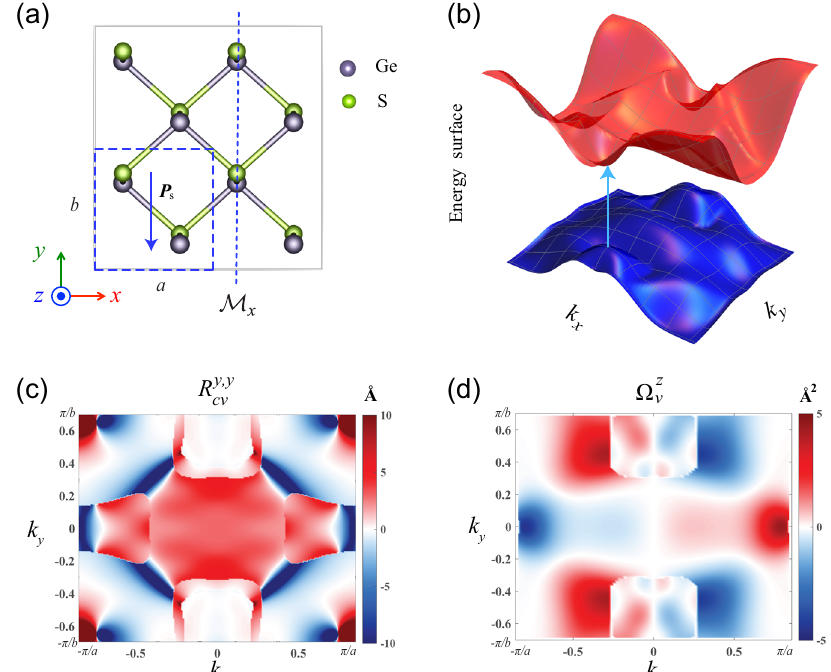
Fig. 3 Crystal structure, band structure, shift vector, and Berry curvature of monolayer GeS. a Crystal structure of ferroelectric monolayer GeS with noncentrosymmetric C 2v point group. b Valence and conduction band energy surfaces across the bandgap. c k -resolved shift vector across the bandgap in the fi rst Brillouin zone. d k -resolved Berry curvature of the top valence band in the fi rst Brillouin zone.